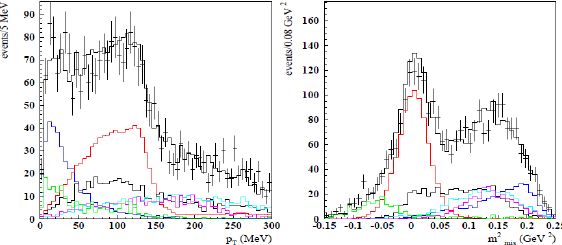
Figure 3: Left : distribution of the transverse momentum of the π + π − system. Right : distribution of the squared missing mass. The contribution of the signal is blue, e + e − → ηγ is red, e + e − → ωπ 0 is